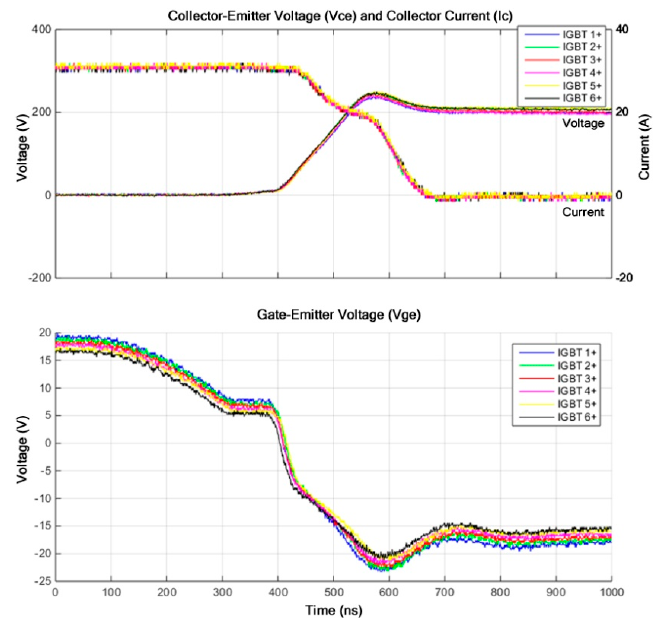
Figure 18. Turn-off switching with 30 A load current showing an excellent voltage sharing among the devices. The Miller and negative gate capacitance effects are clearly seen.